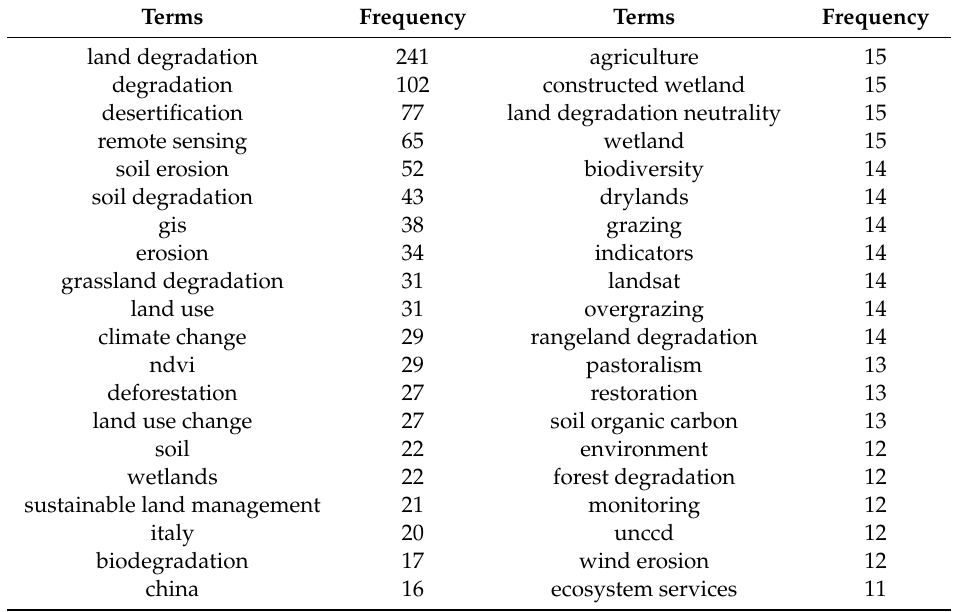
Table A2. High-frequency key words and their frequency of occurrence in the field of land